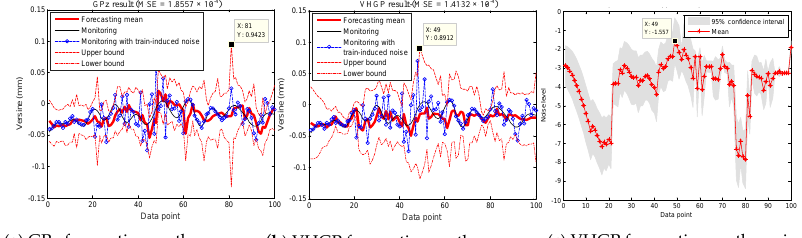
Figure 9. GPz and VHGP forecasting results on laboratory data: ( a ) mean distribution by GPz; ( b ) mean distribution by VHGP; and, ( c ) log-noise distribution by VHGP.